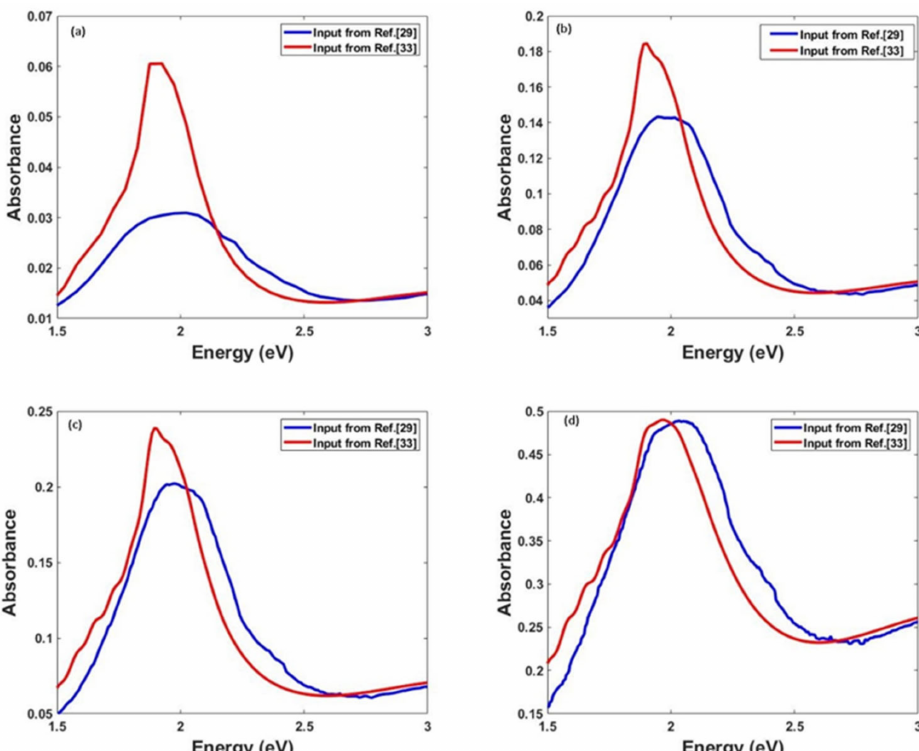
Figure 9. Absorbance spectrum over Energy for Ag NPs, when d = 2, 7, 10 and 50 nm, for the cases ( a – d ), respectively. Comparison between input [29] and input [33].